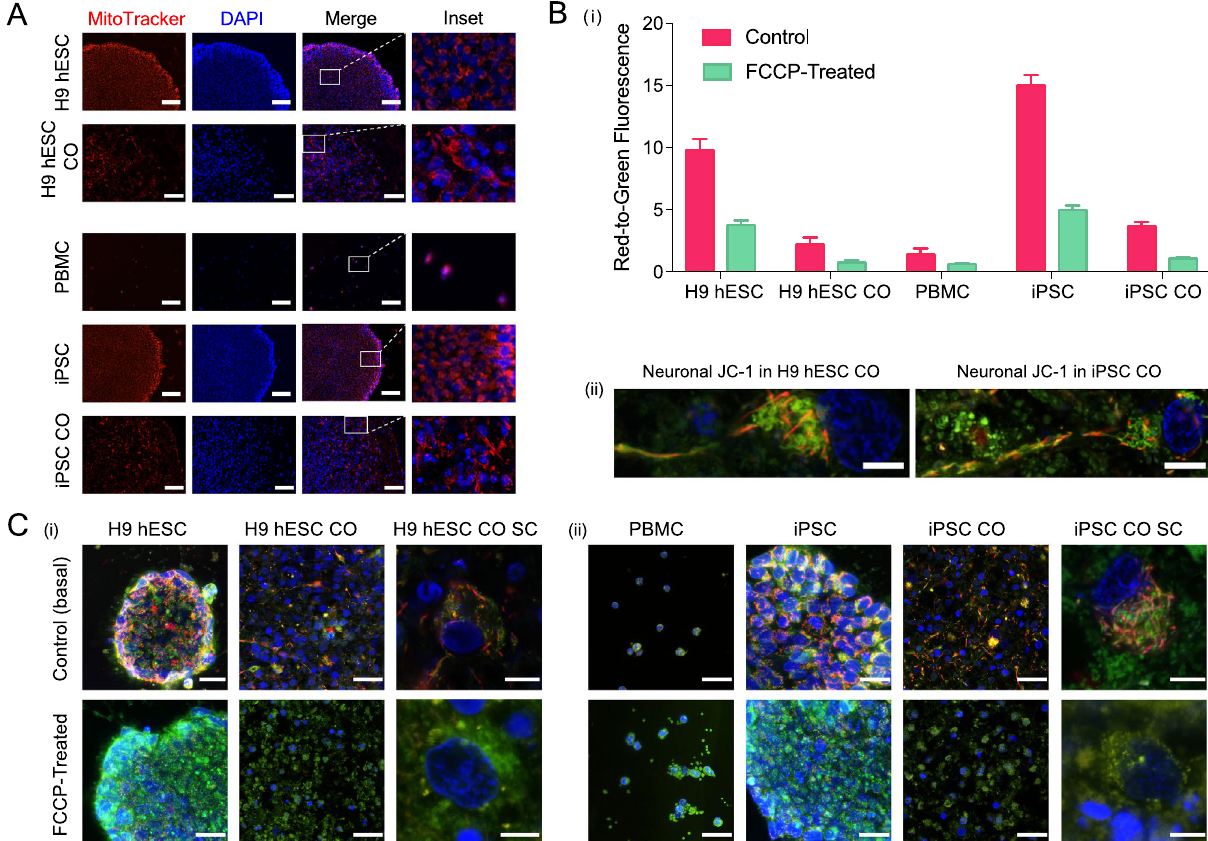
Figure 3. Characterization of active, functional and responsive mitochondria throughout CO generation. ( A ) Active mitochondria in H9 hESCs (scale bar, 100 μm), H9 hESC COs (scale bar, 50 μm), PBMCs (scale bar, 100 μm), iPSCs (scale bar, 100 μm) and iPSC COs (scale bar, 65 μm) stained with MitoTracker Red CMXRos (red) and DAPI (nuclei, blue). Last column shows insets, enlarged views of boxed areas from the merge images. ( B ) (i) Bar graph summarizing mitochondrial membrane potential (MMP) as red-to-green fluorescence ratio across primary, reprogrammed and differentiated stages in samples treated with JC-1 only (control basal MMP level) and those treated with carbonyl cyanide-4-(trifluoromethoxy)phenylhydrazone (FCCP). Fluorescence was recorded using a microplate reader. Bars, mean ± SD; (ii) Representative MMP images of a fully captured neuron with cell body and axon projection in H9 hESC CO (left, scale bar, 5 μm) and iPSC CO (right, scale bar, 7 μm). Red, JC-1 aggregates (highly energetic or polarized), green, JC-1 monomers (less energetic or depolarized). ( C ) (i) Top row shows representative MMP images across CO generation from H9 hESCs (scale bar, 25 μm) to H9 hESC CO (scale bar, 25 μm) or hESC CO single cell (SC, scale bar, 10 μm) and; (ii) from PBMCs (scale bar, 25 μm) to iPSCs (scale bar, 25 μm) to iPSC COs (scale bar, 25 μm) or iPSC CO SC (scale bar, 5 μm). Bottom row shows representative images of samples treated with FCCP followed by JC-1 to visualize the collapse of MMP in (i) H9 hESCs (scale bar, 25 μm) to H9 hESC CO (scale bar, 25 μm) or hESC CO SC (scale bar, 5 μm) and; (ii) from PBMCs (scale bar, 25 μm) to iPSCs (scale bar, 25 μm) to iPSC COs (scale bar, 25 μm) or iPSC CO SC (scale bar, 5 μm). All images were captured at ×100 magnification with slight variations in the zoom factor to capture the single cell(s) or single colony of interest. Immunofluorescent images shown here were used for qualitative observations